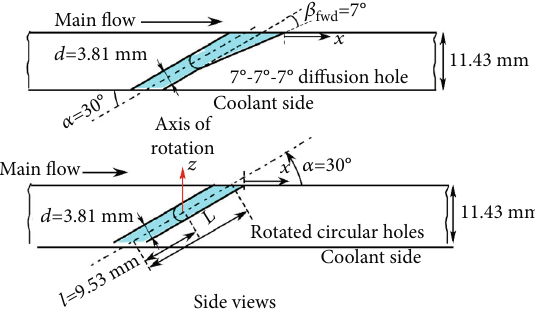
Figure 2: Test plate cross-section with fi lm holes side